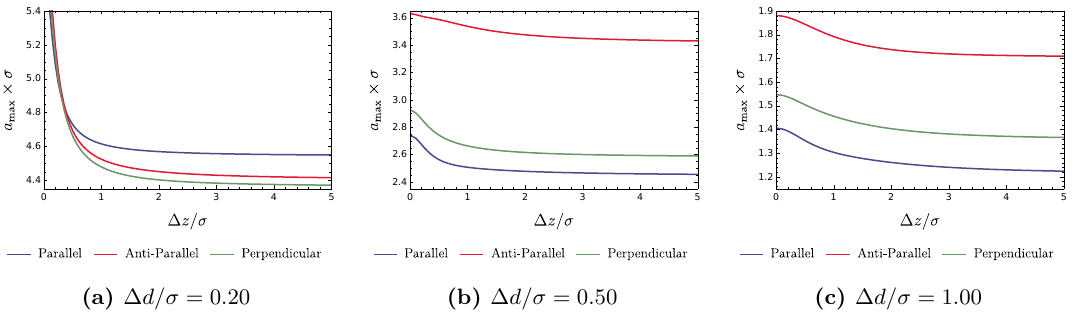
Figure 13. The plot of the threshold acceleration, a max , is shown as a function of the distance be- tween detectors and the boundary for the three acceleration scenarios. Here, we have set Ω σ = 0 . 10 and ∆ d/σ = { 0 . 20 , 0 . 50 , 1 . 00 } in the left-to-right